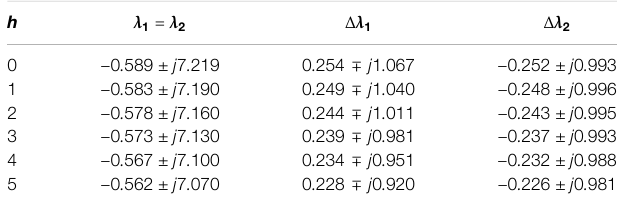
TABLE 5 | Calculation results when the electrical distance between each of PV farms and the main grid remains unchanged.